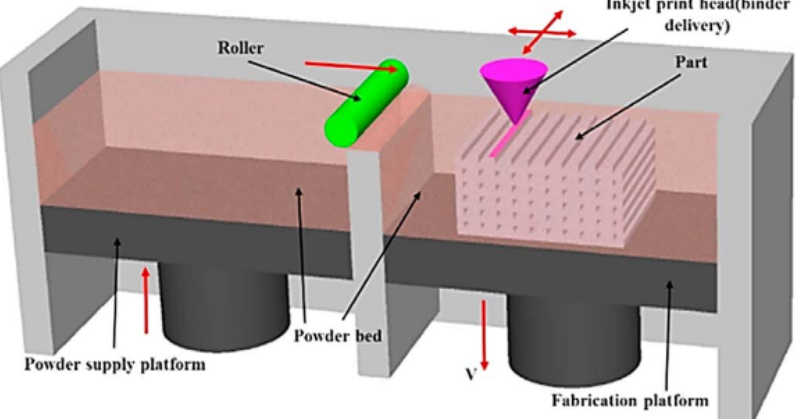
Figure 5. A schematic diagram of inkjet printing [50] Copyright 2016 Copyright Elsevier Ltd.